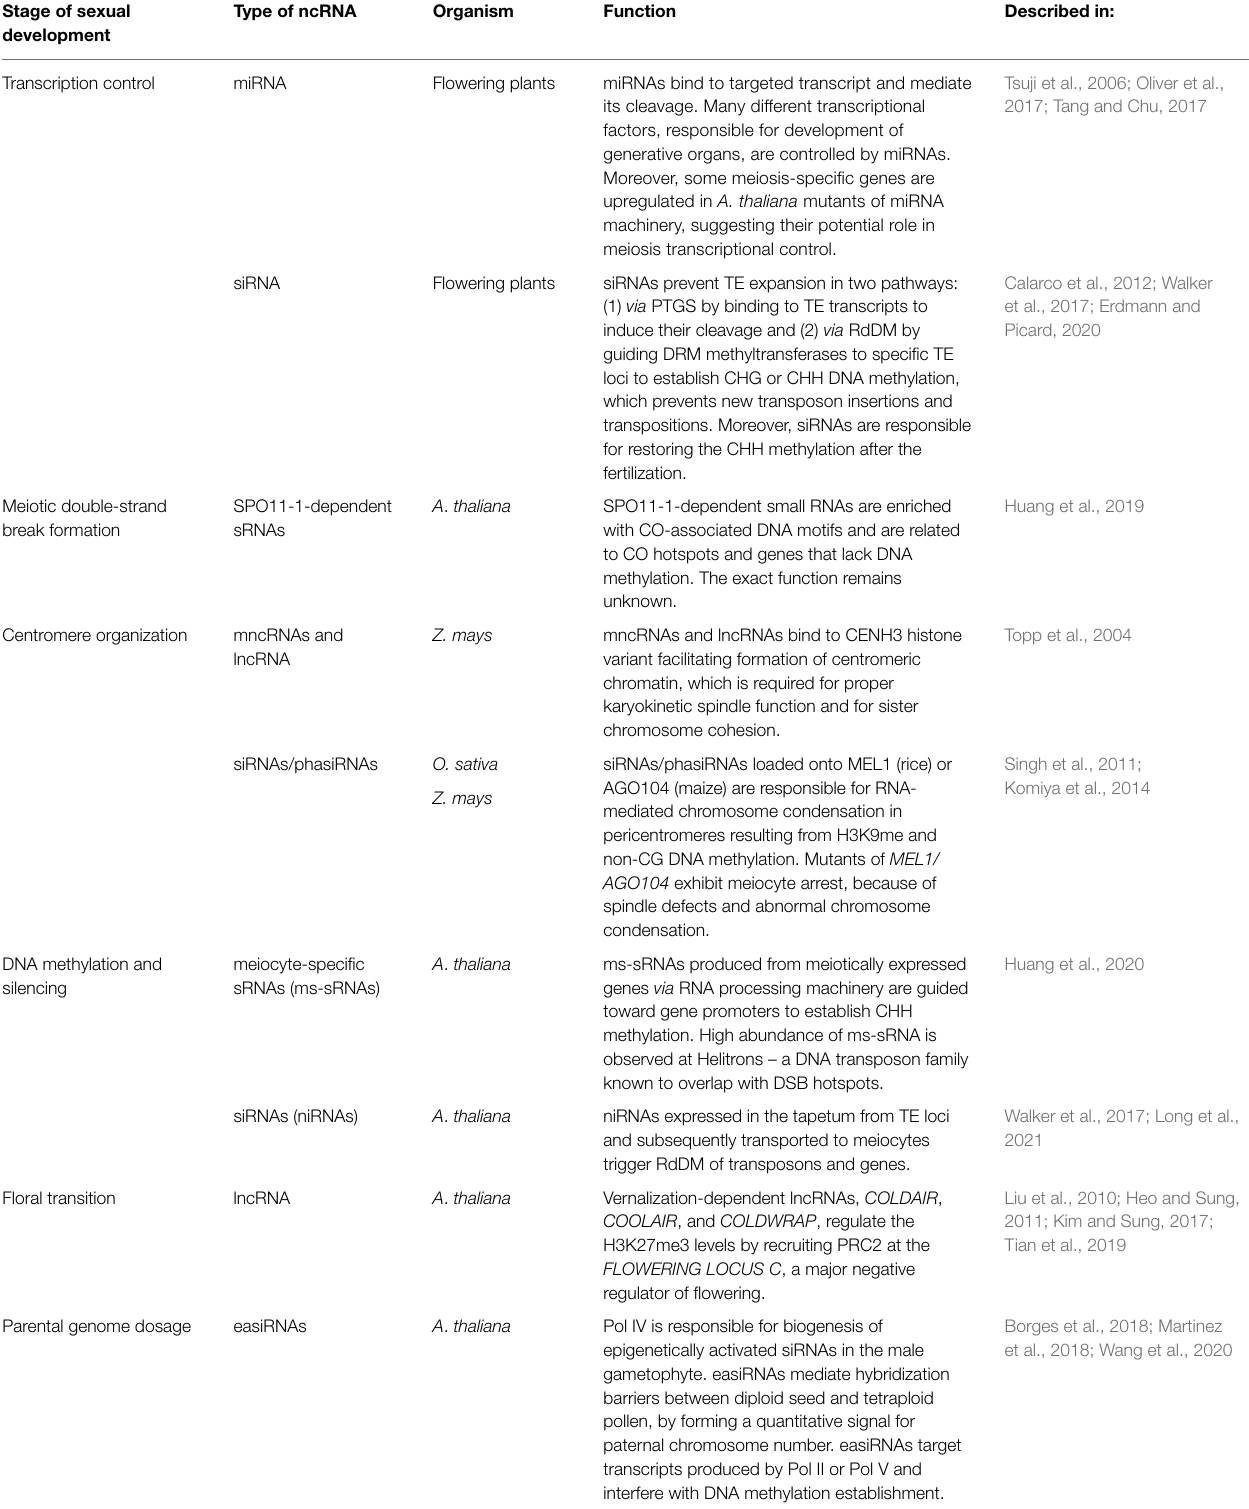
TABLE 1 | Role of ncRNAs in plant meiosis and